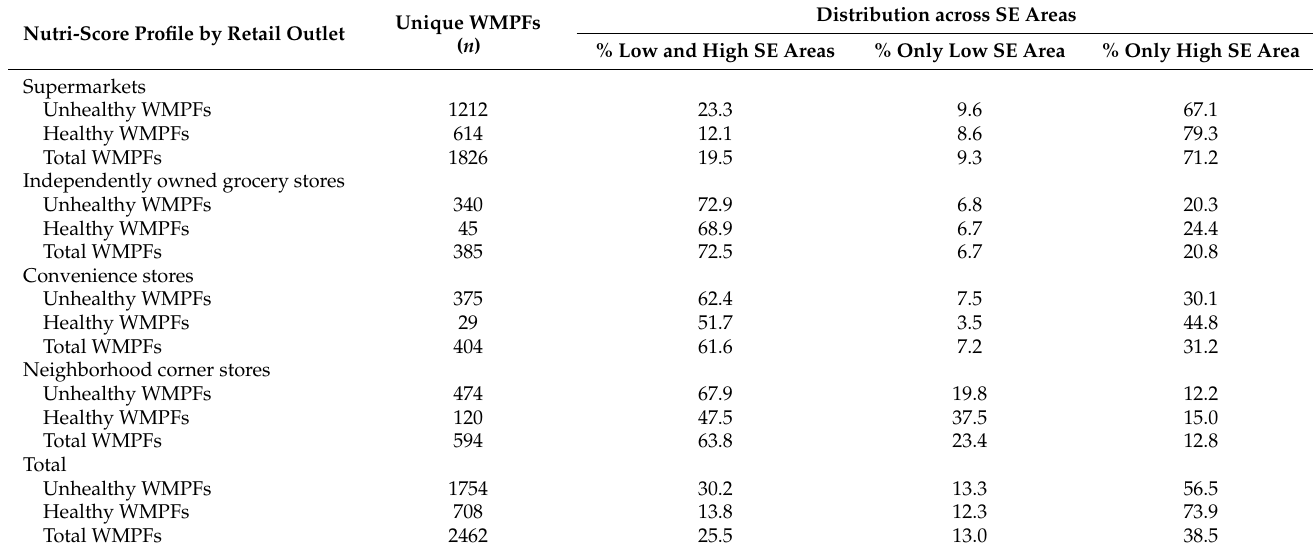
Table 1. Distribution of healthy and unhealthy wheat and maize processed foods (WMPFs) across food retail outlets and socioeconomic areas.